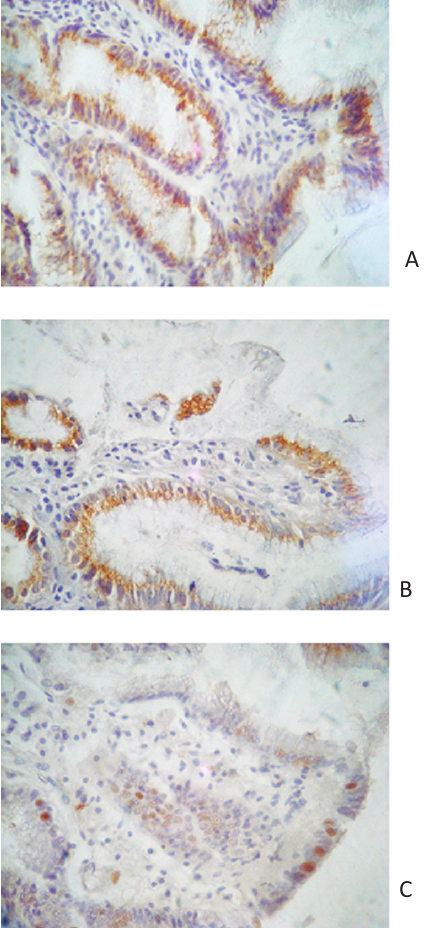
Fig. 1. Immunohistochemical localization of ATG16L1 (A), LC3C (B) and vacA (C), stained by specific primary and visualized by peroxidase staining system on gastritis tissue section. 400X original vacA